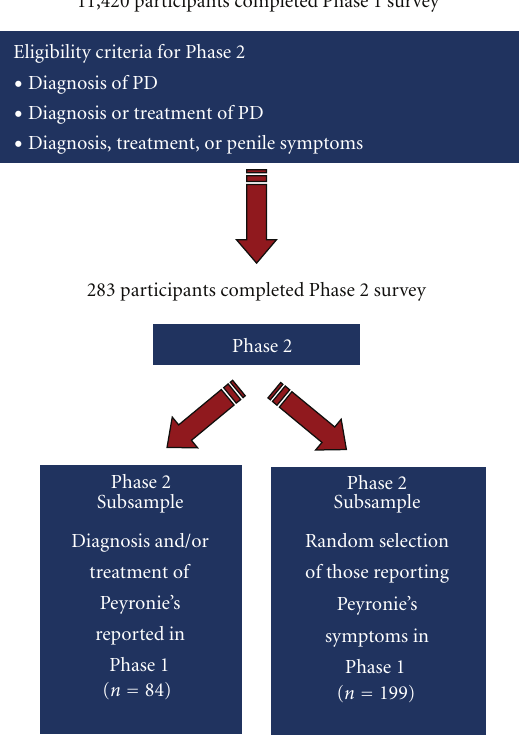
Figure 1: Diagram of study design. Data for this study were collected in 2 phases. In Phase 1, panel participants were screened for the presence of symptoms, past treatment, and a diagnosis of Peyronie’s disease. In Phase 2, eligibility to complete the full survey was determined by participants’ responses to the screening items in Phase 1. KN = Knowledge